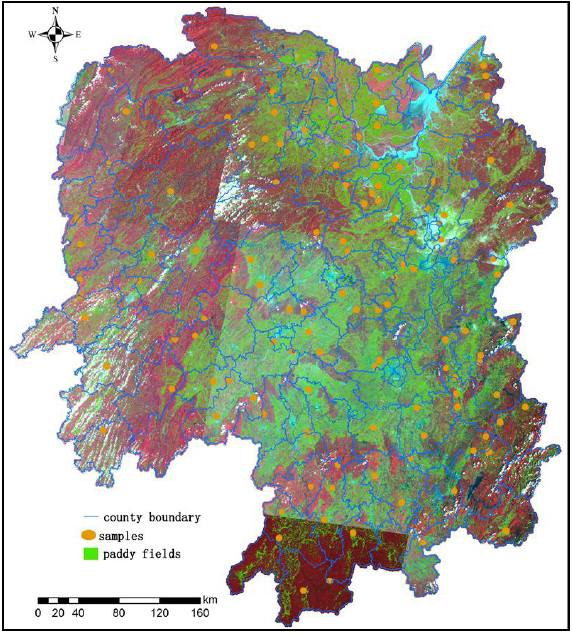
Figure 1. The distribution of HJ images, paddy fields and ground survey data in Hunan